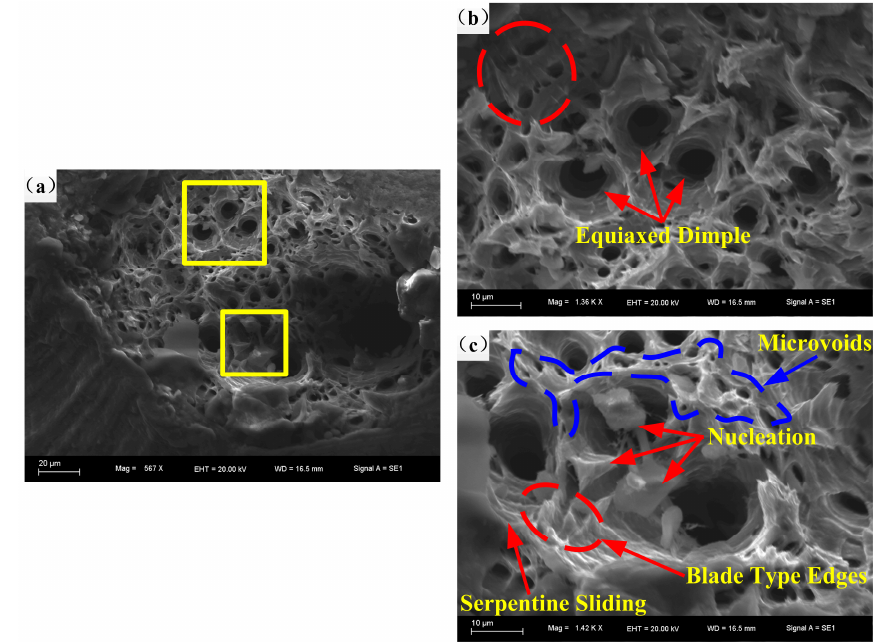
Figure 13. Fracture morphology at 400 °C and at strain rate of ( a – c ) 10 − 1 s − 1 .